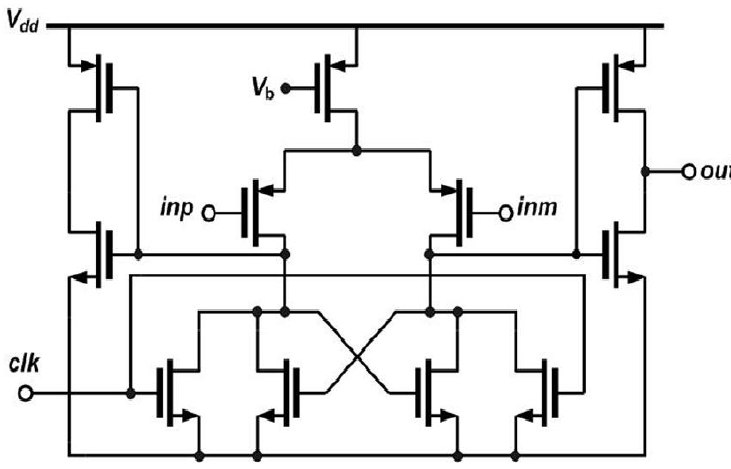
Figure 8. Schematic of the regenerative resettable